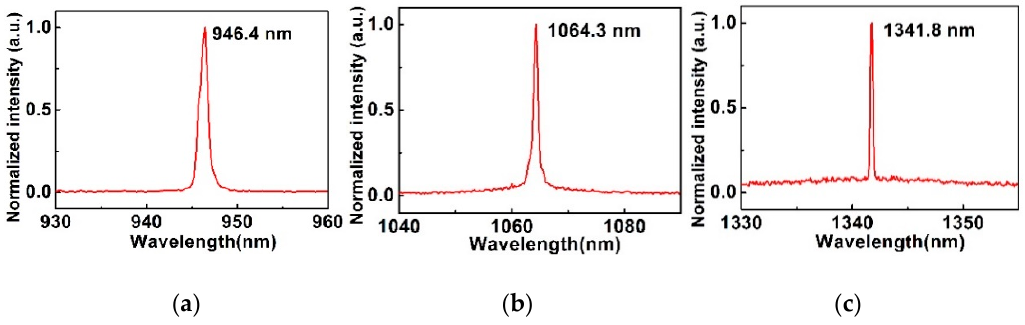
Figure 5. The output spectra of Si nanosheets based Q-switched lasers. at ( a ) 0.9, ( b ) 1.06, and ( c ) 1.3 µm.